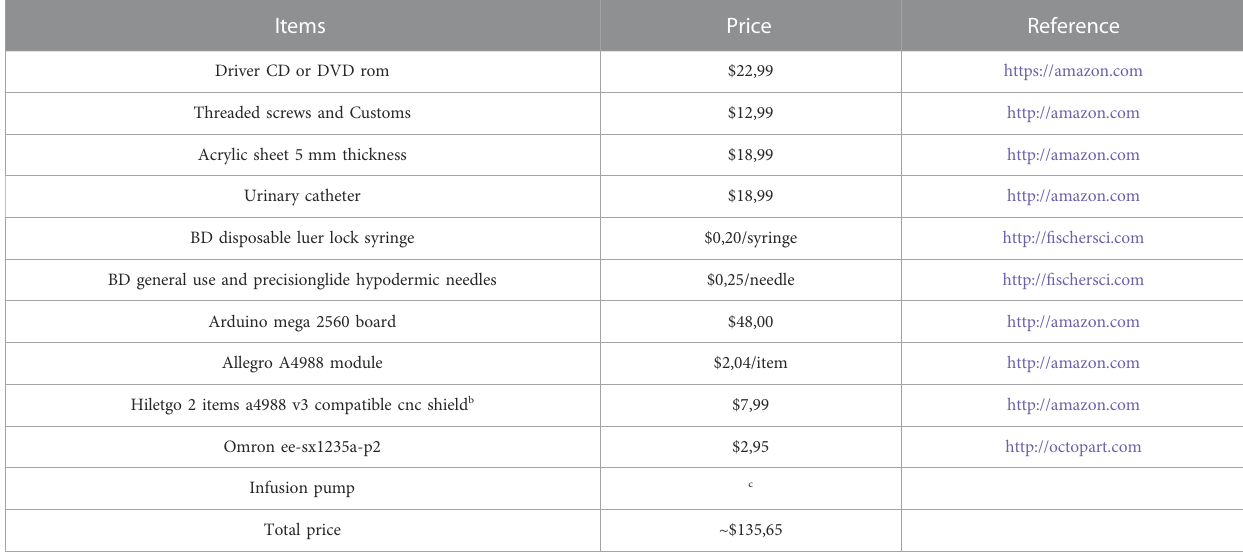
TABLE 5 Prices of materials to build the 3D bioprinter a